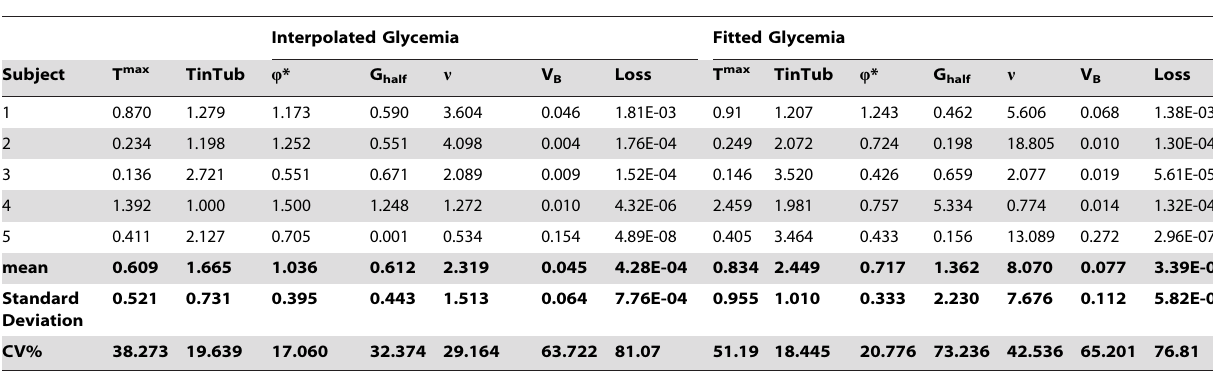
Table 6. Parameter estimation for the PTR